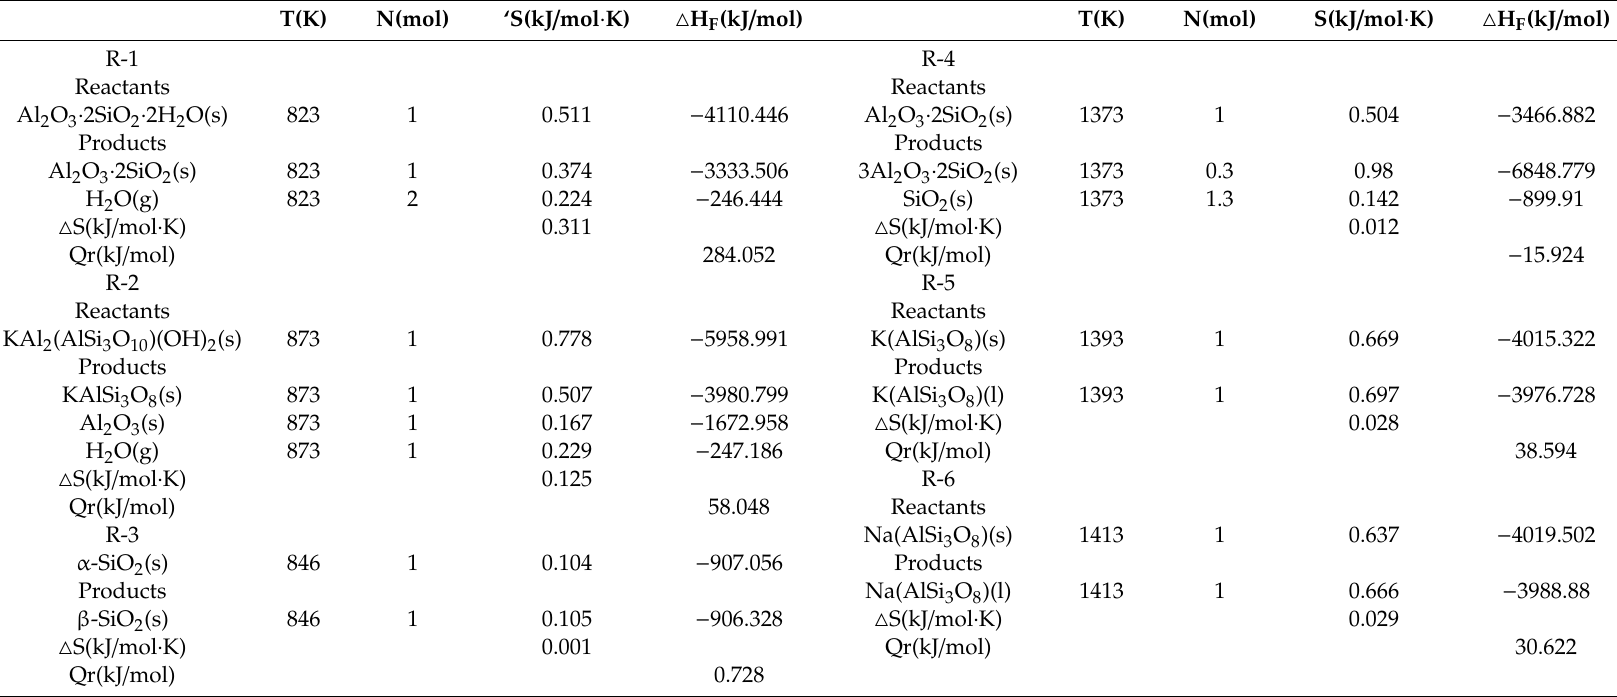
Table 8. The entropy and enthalpy of the substances participating in the chemical